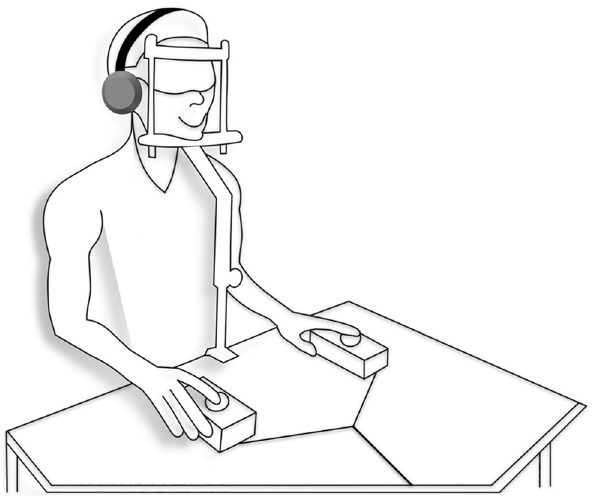
Fig 1. Experiment set-up. Illustration of the experimental setup with pushbuttons used to navigate throughout the virtual environments. Maintaining coil placement over the hotspot is crucial, therefore a chin-headrest was used to maximize